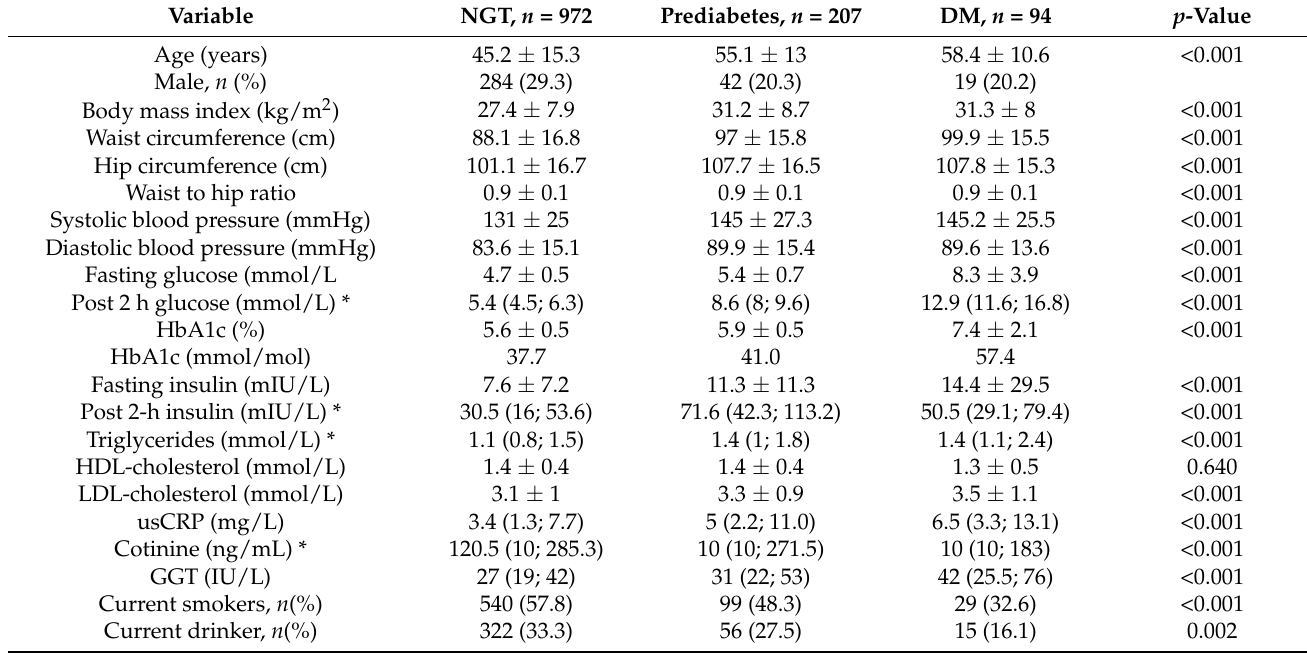
Table 1. Characteristics of the study participants.